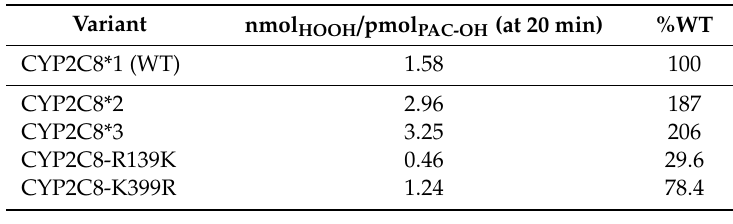
Table 2. Hydrogen peroxide (HOOH) production per PAC turnover. The amount of HOOH formed at 20 min was divided by the amount of PAC–OH produced at 20 min. These values are compared to WT.